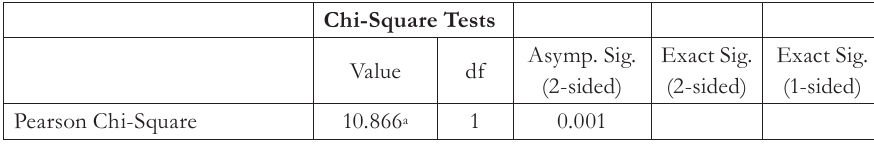
Tab. 5 - Satisfaction with price of provided banking products versus paying charges. Source: Author´s own,